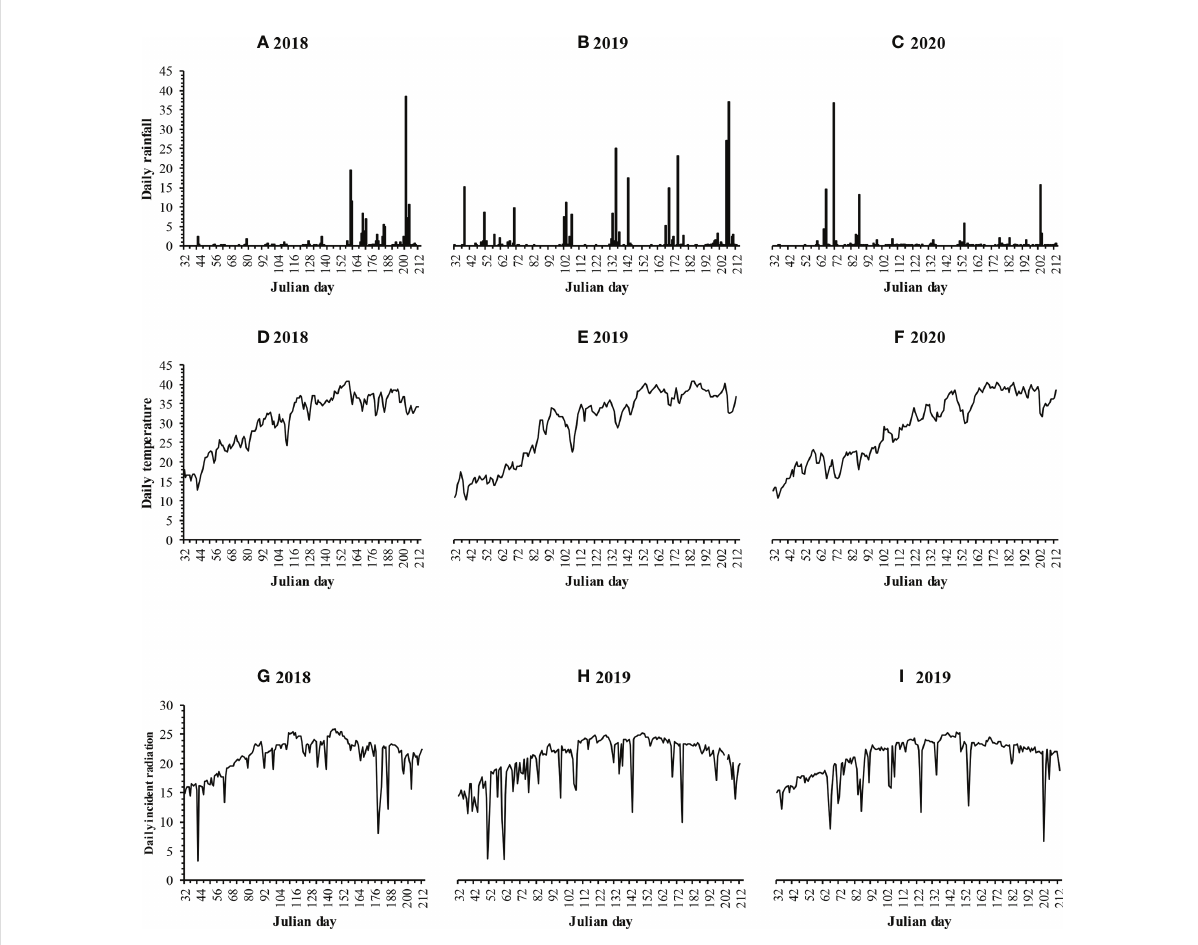
FIGURE 1 Daily rainfall (mm), temperature (°C), and incident radiation (MJ m -2 day -1 ) during the summer season of maize and soybean in 2018, 2019, and